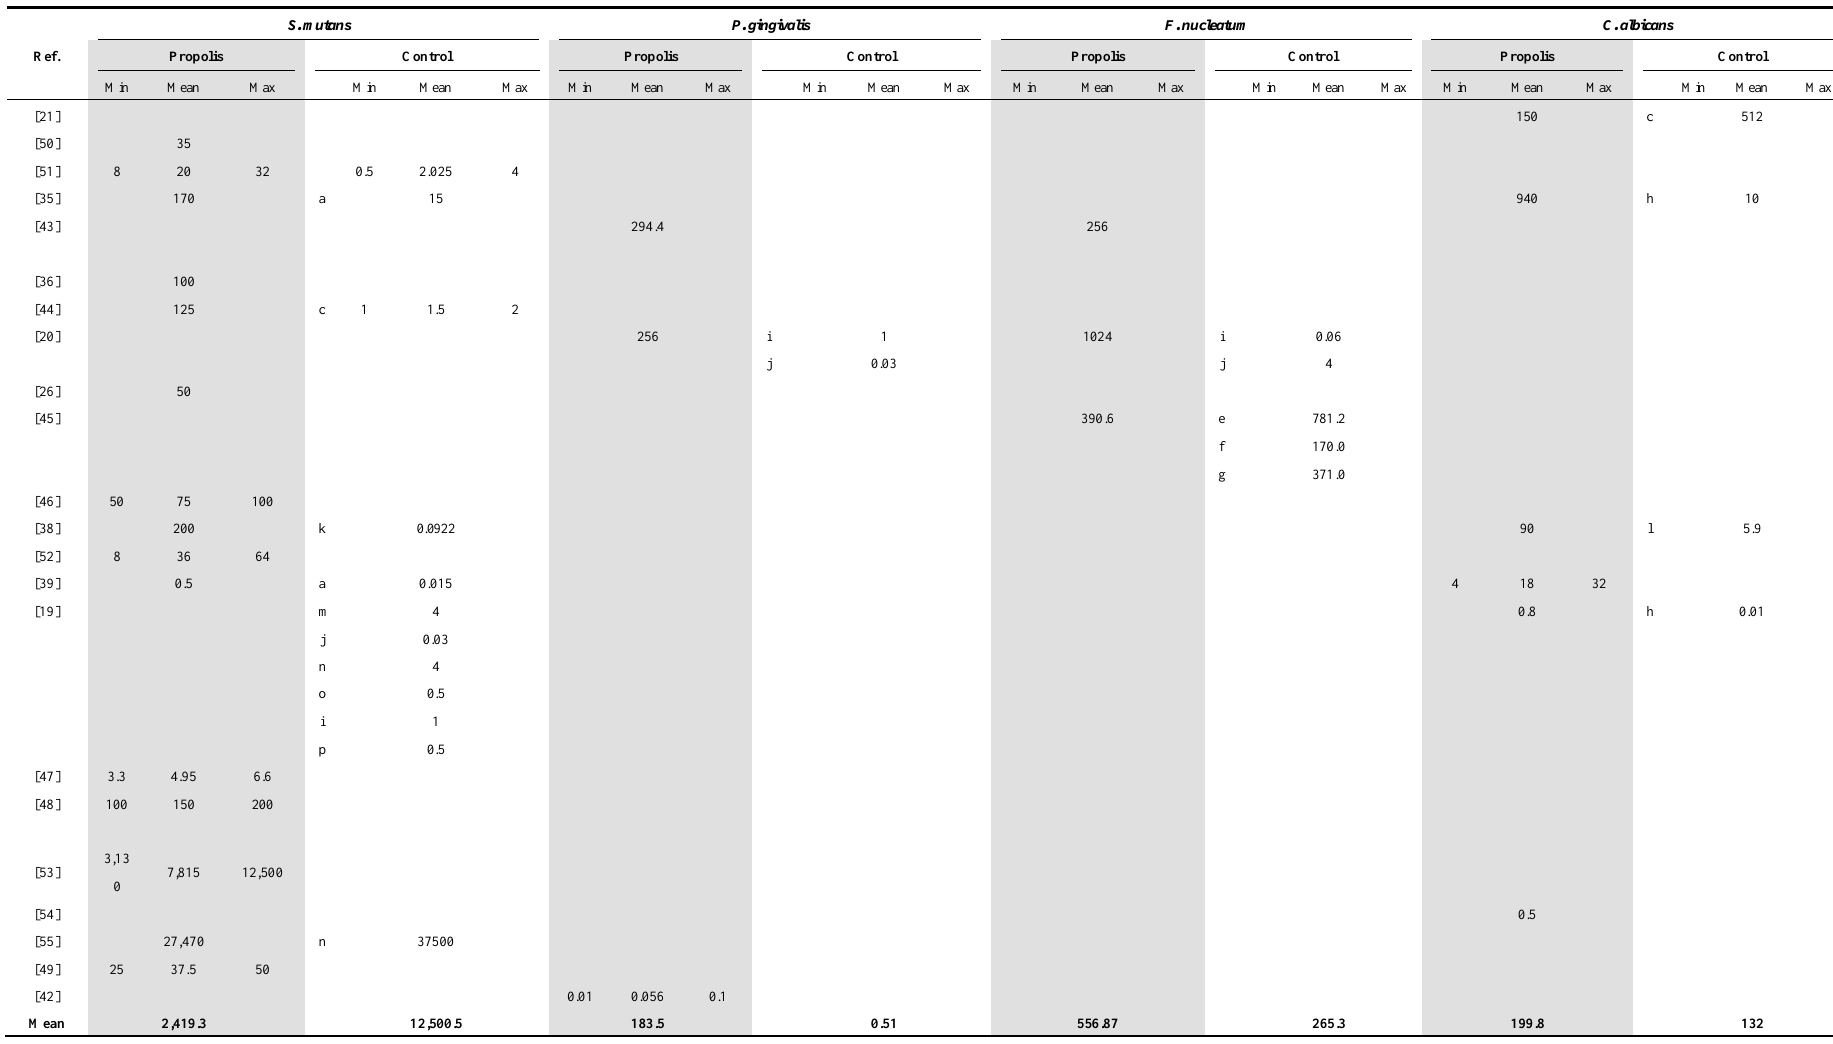
Table 3. MIC (minimal inhibitory concentration; µg/mL) of propolis and control compounds (indicated with different superscript letters).